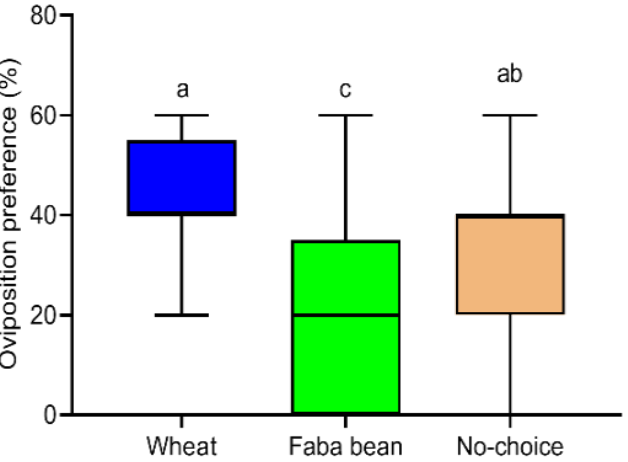
Figure 5. The median preference of S. frugiperda female moths to the odors emitted from wheat and faba bean plants in Y-tube olfactometer tests. Different letters above the bars indicate significant differences among groups (nonparametric Kruskal–Wallis tests, p < 0.05).